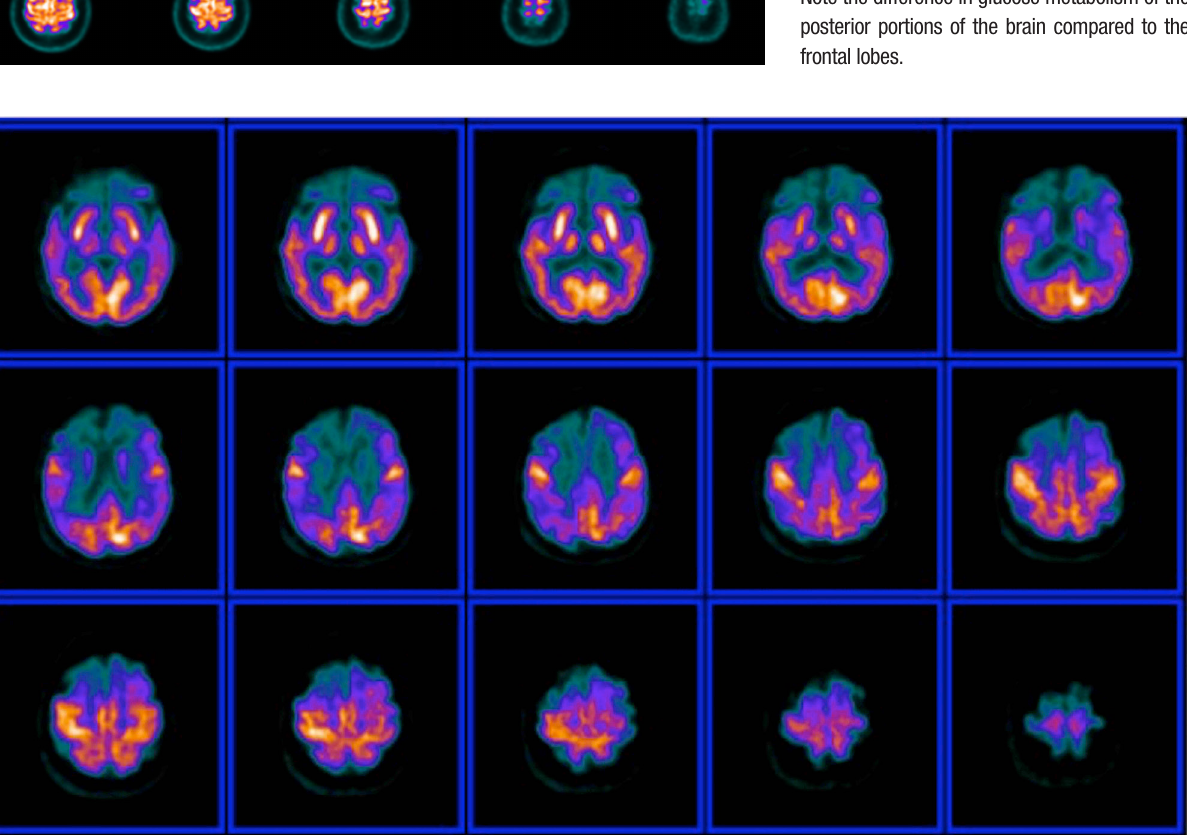
Figure 2. FDG-PET of a patient with Alzheimer’s disease. Transversal slices show marked hypo- metabolism in the posterior cingulate cortex and posterior temporoparietal association cortex. Note the difference in glucose metabolism of the posterior portions of the brain compared to the frontal lobes.